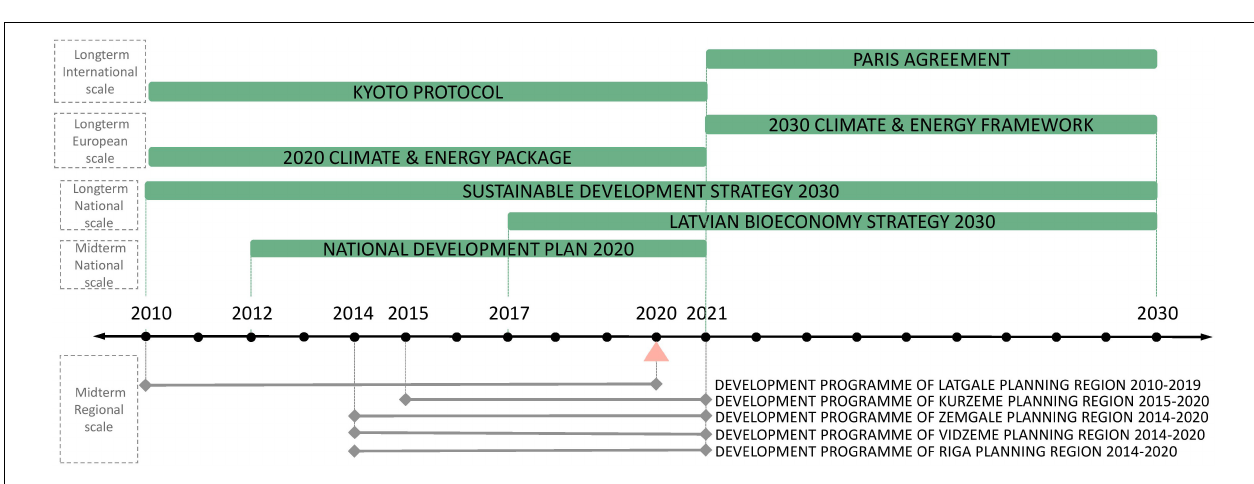
FIGURE 7 | Summary of policies used for quantification of the